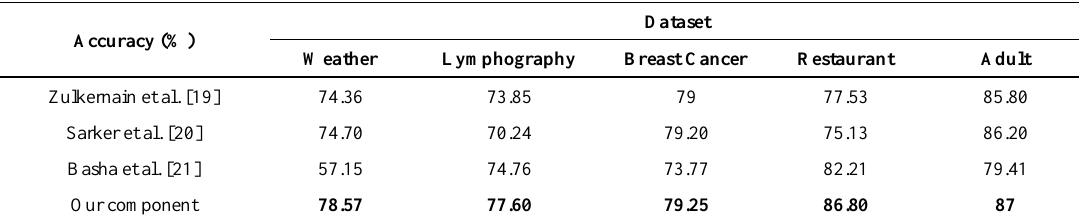
Table 3. Accuracy comparison with state-of-the-art approaches on five